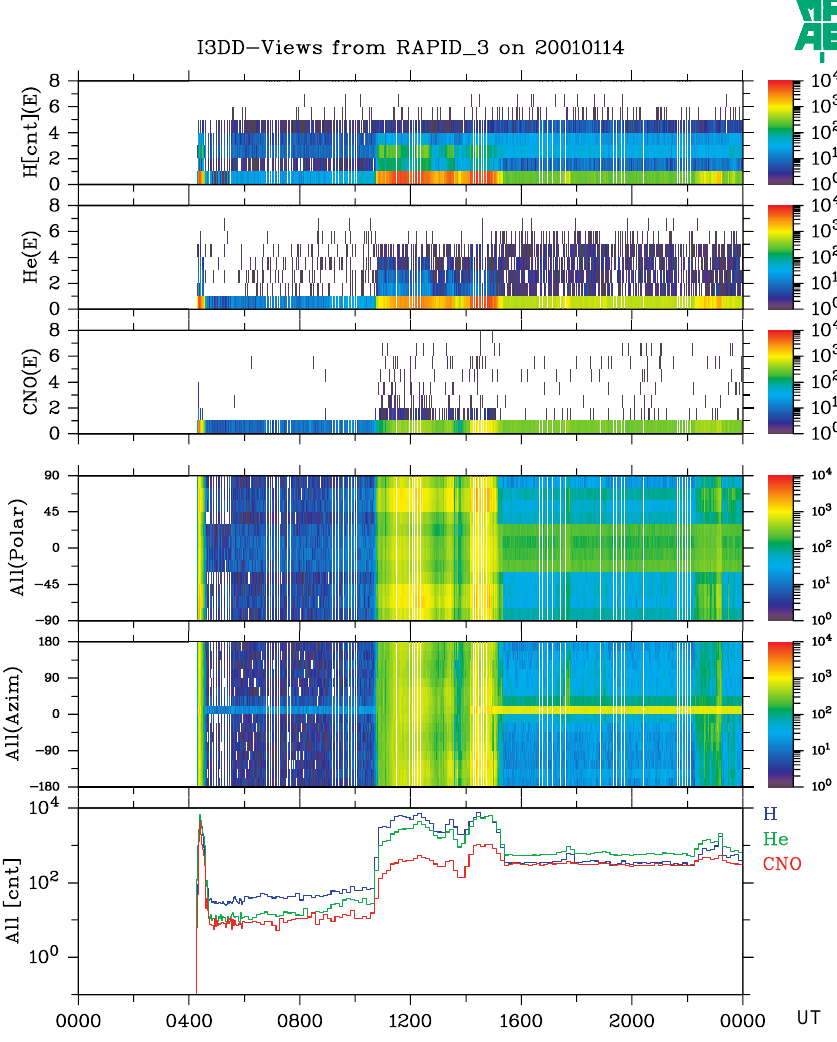
Fig. 4. Count rates measured by RAPID on spacecraft 3 on 14 January 2001. The panels show from top to bottom the H, He CNO count rates, the polar distribution of the total count rate, the azimuthal total count rate and the total accumlated count